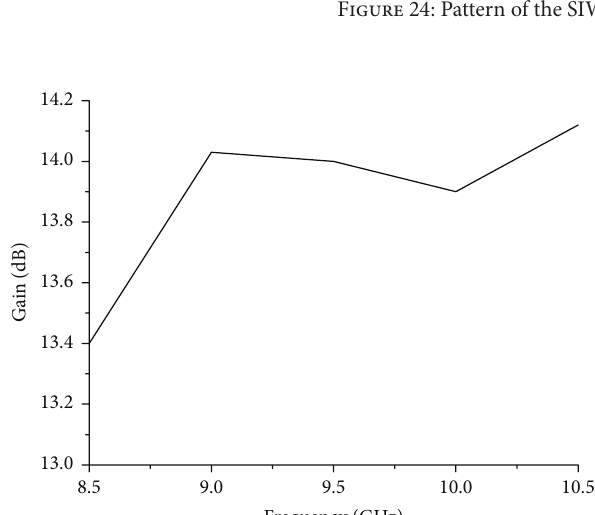
Figure 25: Simulated gain of the SIW Vivaldi antenna array.